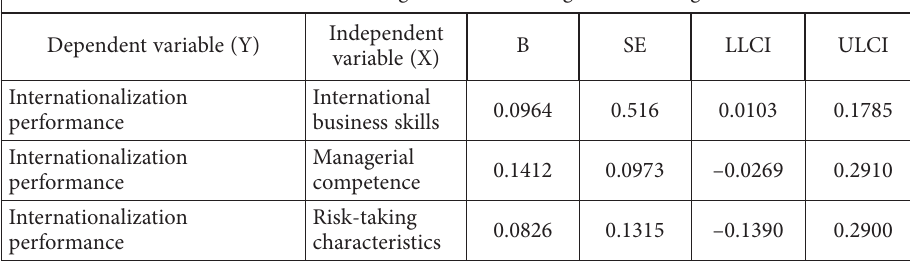
Table 3. The results of mediation analysis (source: own calculations) Indirect effect of X on Y through mediator – usage of knowledge and skills Independent Dependent variable (Y) variable